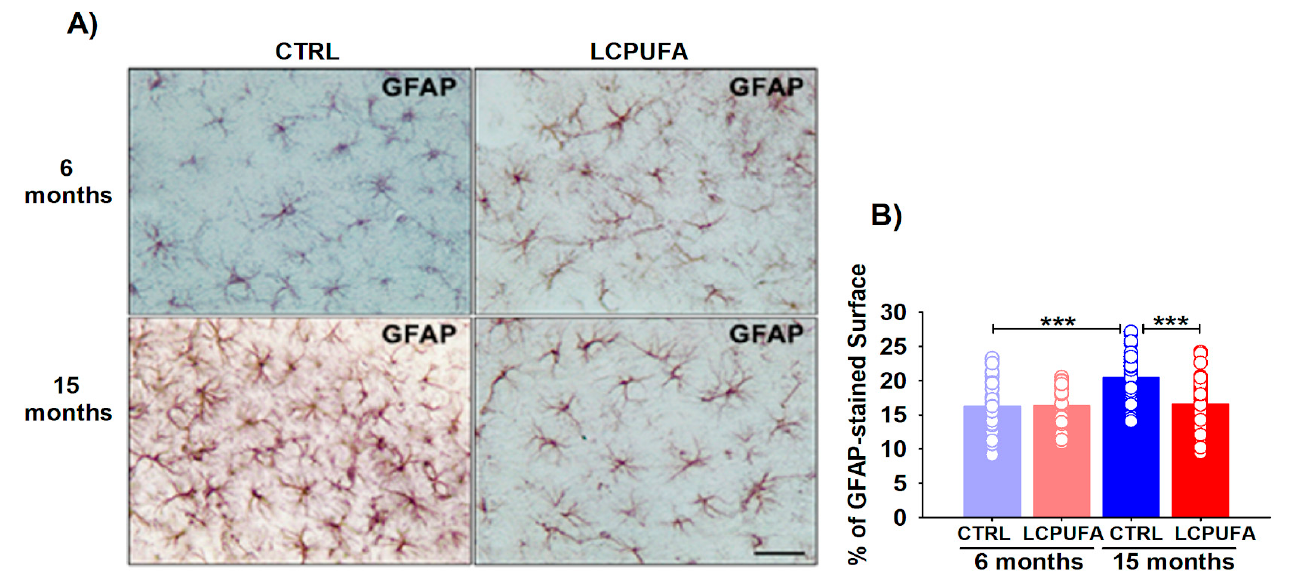
Figure 4. Astrocytic changes from young and aged female mice. ( A ) Representative images of GFAP immunostaining. A n-3 LCPUFA-enriched diet normalizes astrocytes hypertrophy induced by aging in the hippocampus of female mice. Immunohistochemistry was performed in fixed horizontal brain slices from 6- and 15-months-old female mice fed CONTROL or n-3 LCPUFA-enriched diets as indicated in the Methods. Scale bar = 40 μ m. ( B ) Astrocytes covering area is increased in the hippocampus of 15-months-old female mice. A n-3 LCPUFA-enriched diet normalizes the astrocyte’s covering area. Bars represent the mean astrocytes covering area (%) ± SEM from 33–41 40× fields per group, measured as described in the Methods. Circles represent each individual measurement. Data were analyzed by a 2-way ANOVA (diet, age) and Tukey’s post hoc test (*** p < 0.001). n = 4 animals per group.